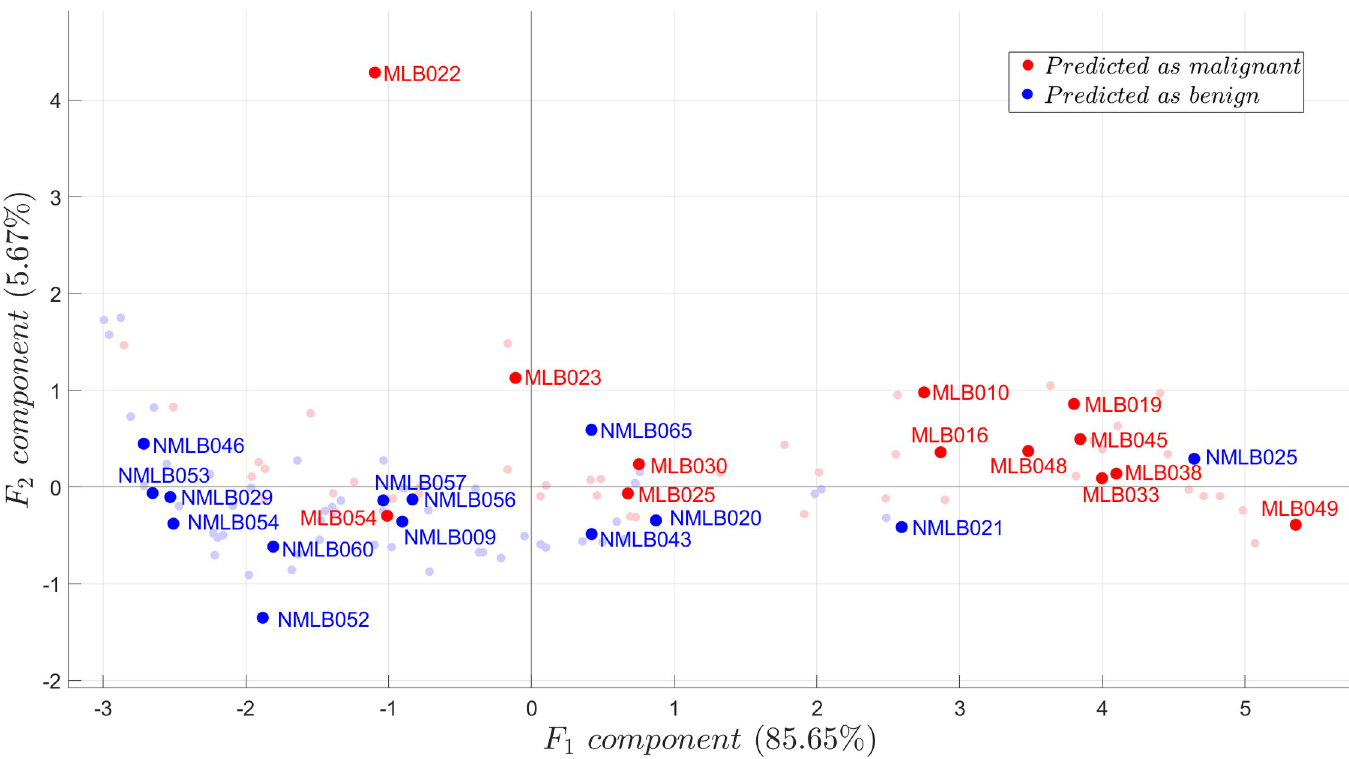
Fig 8. Distribution of discordant samples from concordant samples via PCA. The plot shows the diagnosis of the models per discordant samples (dark-colored points) over the distribution of concordant malignant samples (light red) and concordant benign (light blue) samples. The diagnoses of the models for all discordant samples were consistent with the original diagnoses of the study